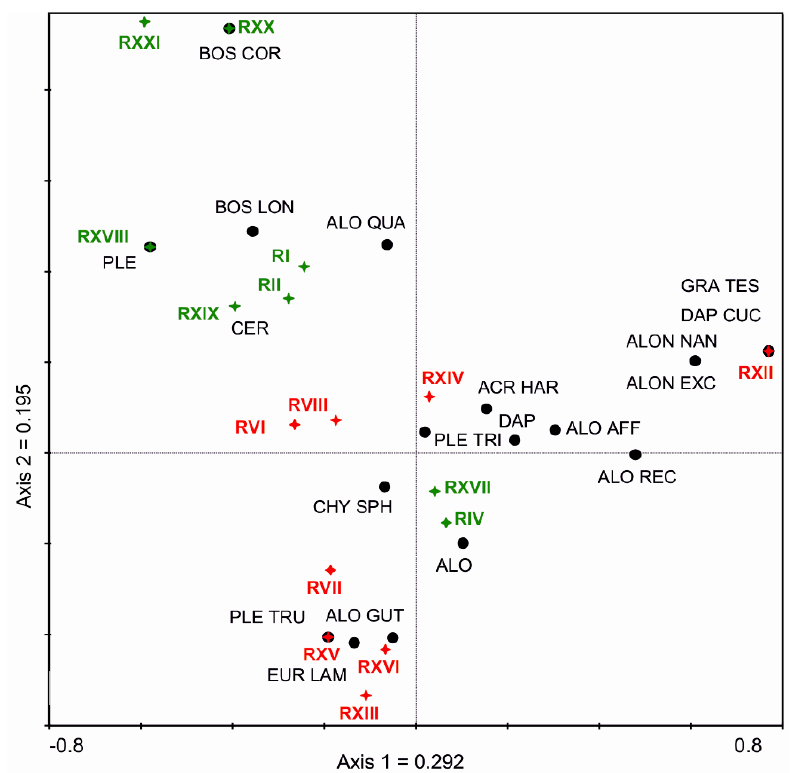
Figure 6. Correspondence analysis (CA) diagram for Cladocera fauna in sediment cores of subsidence ponds (ACR HAR: Acroperus harpae ; ALO: Alona sp.; ALO AFF: A. a ffi nis ; ALO GUT: A. guttata ; ALO QUA: A. quadrangularis ; ALO REC: A. rectangula ; ALON EXC: Alonella excisa ; ALON NAN: A. nana ; BOS COR: Bosmina coregoni ; BOS LON: B. longirostris ; CER: Ceriodaphnia sp.; CHY SPH: Chydorus sphaericus ; DAP: Daphnia sp.; DAP CUC: D. cucullata ; EUR LAM: Eurycercus lamellatus ; GRA TES: Graptoleberis testudinaria ; PLE: Pleuroxus sp.; PLE TRU: P. truncatus ; PLE TRI: P. trigonellus ). UP: Sediment cores are marked in green color; DOWN: Sediment cores are marked in a red